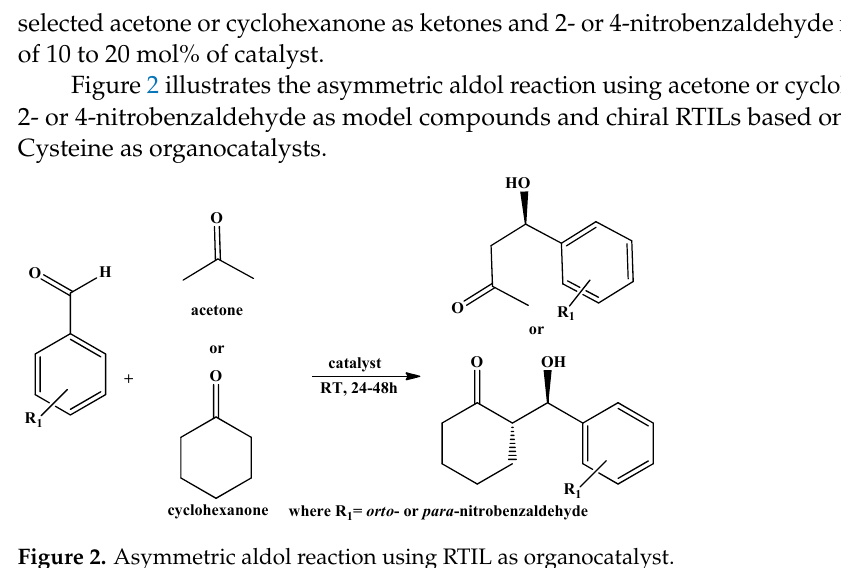
Figure 2. Asymmetric aldol reaction using RTIL as organocatalyst.